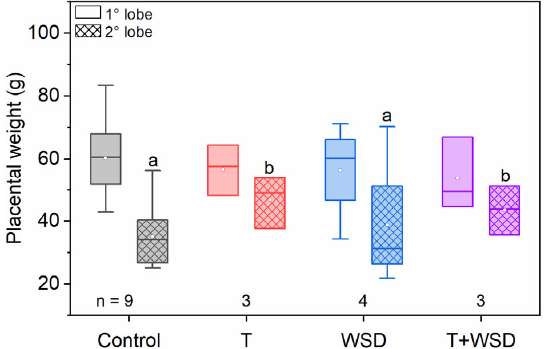
Figure 2. Testosterone (T) increased weights of the secondary (2 ◦ ) placental lobe. Cesarean section delivery was performed at gestation day 135 after ultrasound procedures. Lettering depicts significant differences for the interaction between placental lobe and T treatment ( F 1,14 = 5.11, p = 0.04).